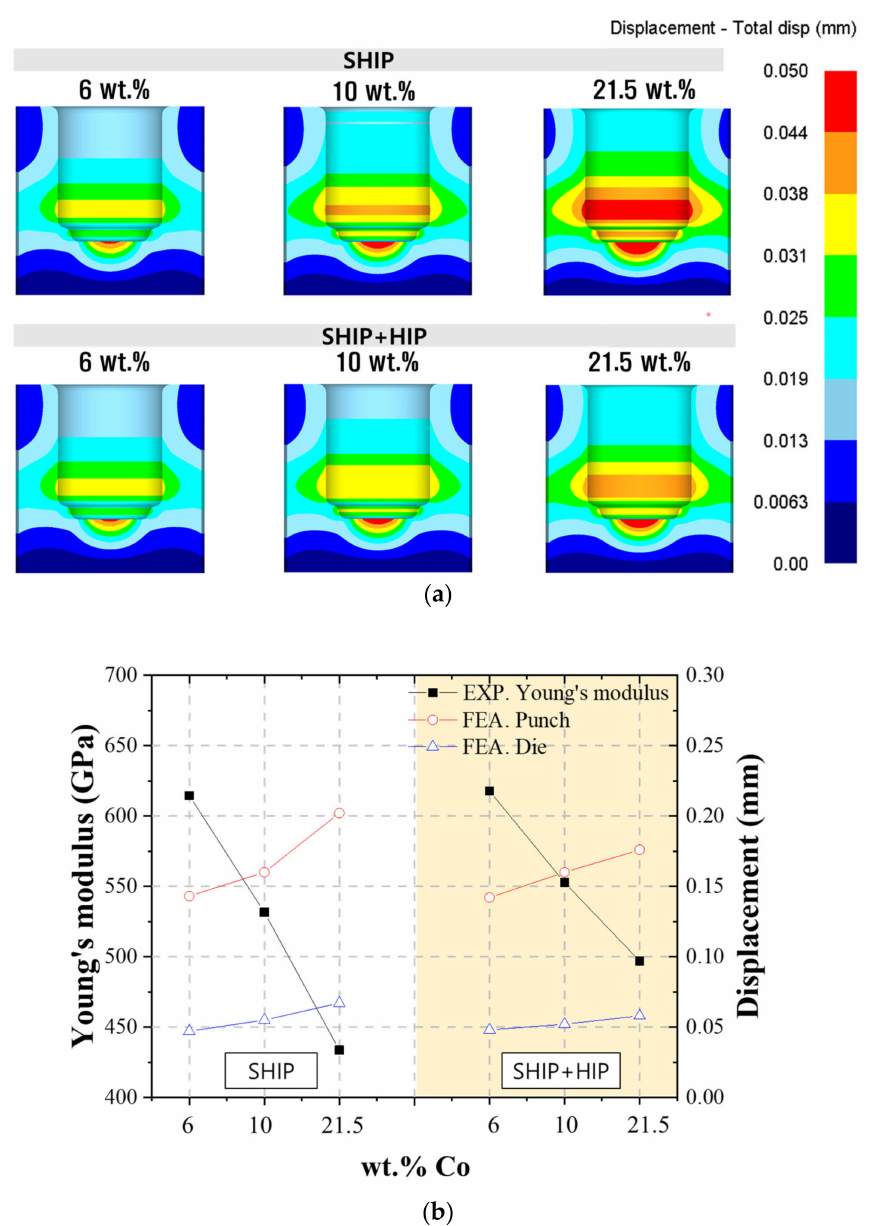
Figure 14. ( a ) Results of die stress analysis distribution and ( b ) comparison of young’s modulus and displacement according to Co content and Hip